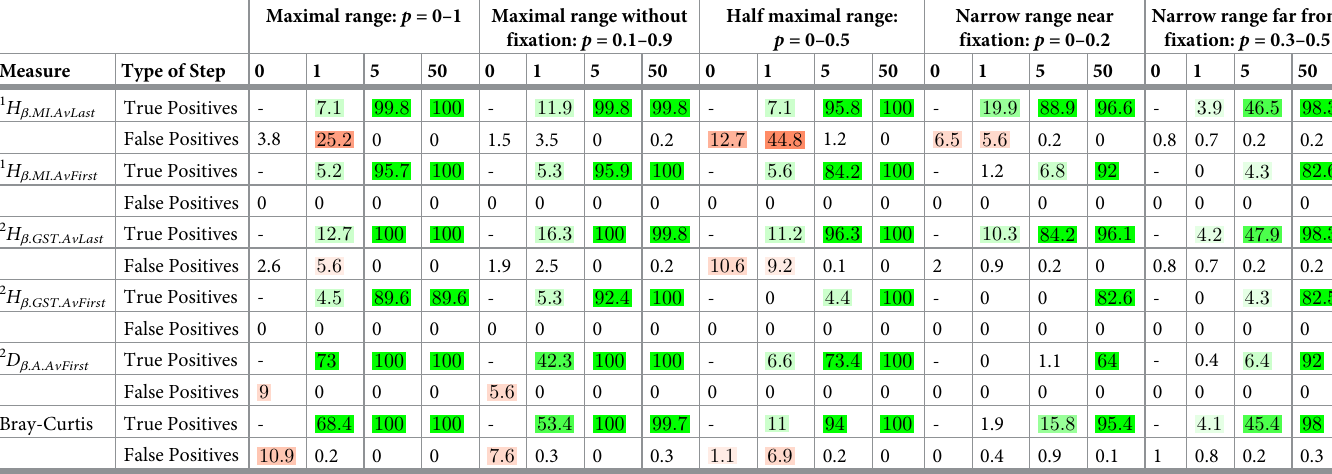
Table 3. Step detection sensitivity, averaged over all optimal and suboptimal conditions, for the best six diversity measures (Mutual Information AvLast variant, Mutual Information AvFirst variant, G ST AvLast variant, G ST AvFirst variant, 2 D β . A . AvFirst , and Bray-Curtis) across five allele proportion treatments ( p = 0–1, p = 0.1–0.9, p = 0–0.5, p = 0–0.2, p = 0.3–0.5), each with four step treatments (linear– 0, gentle step– 1, moderate step– 5, steep step– 50). Both true positives (where a step was detected at the correct location, d = 0.5) and false positives (where a step is detected at the wrong location or any location for the linear treatments) are shown. Val- ues are in percentages, averaged across all tested simulations (where genome sample size, number of loci and number of localities was varied. Remaining percentages (out of 100) for each treatment were simulations where no step was detected (true negatives for the linear treatments, false negatives for the step treatments). Darker green rep- resents higher percentages of true positives, darker red represents higher percentages of false positives. Comprehensive data are shown in Supplement S3